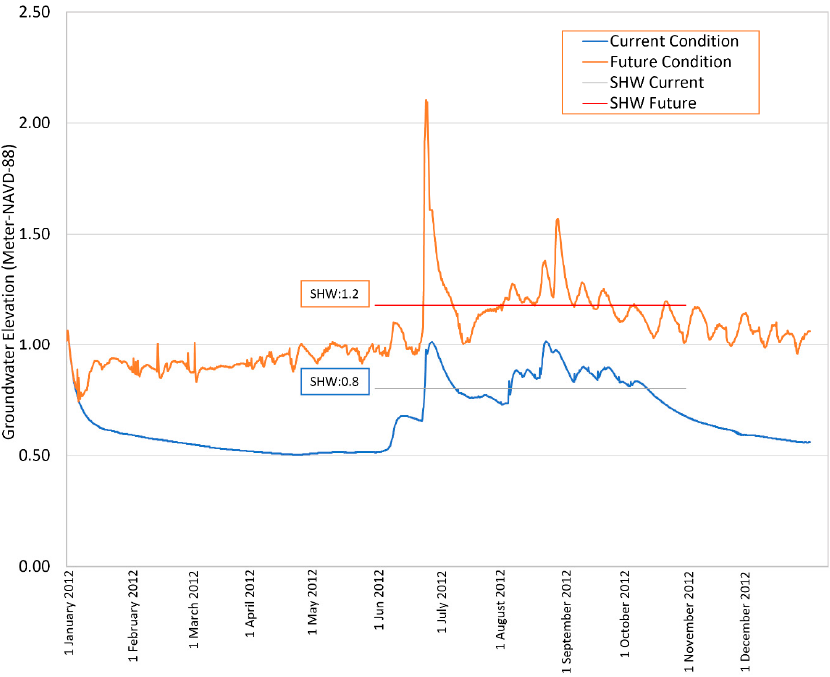
Figure 9. Groundwater elevation and SHW at project location for current and future conditions.